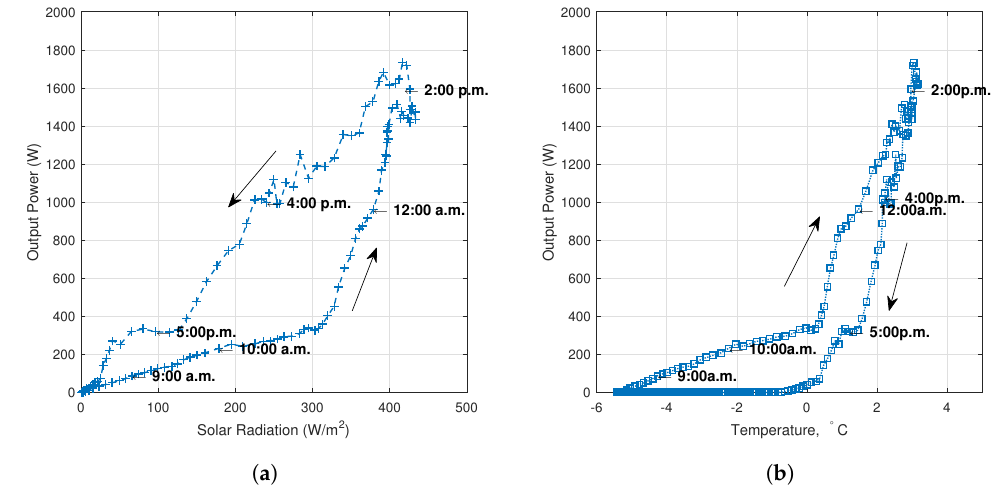
Figure 6. ( a ) Solar radiation to output power; ( b ) Temperature to output